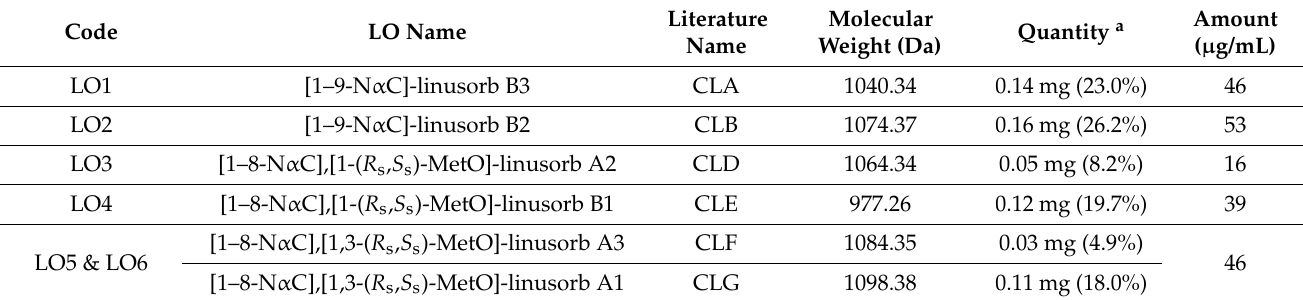
Table 1. The abbreviations of components in LOMIX and its